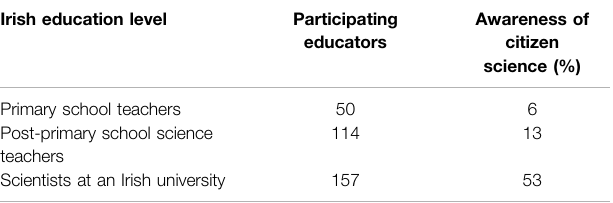
TABLE 3 | Awareness of citizen science across the Irish education